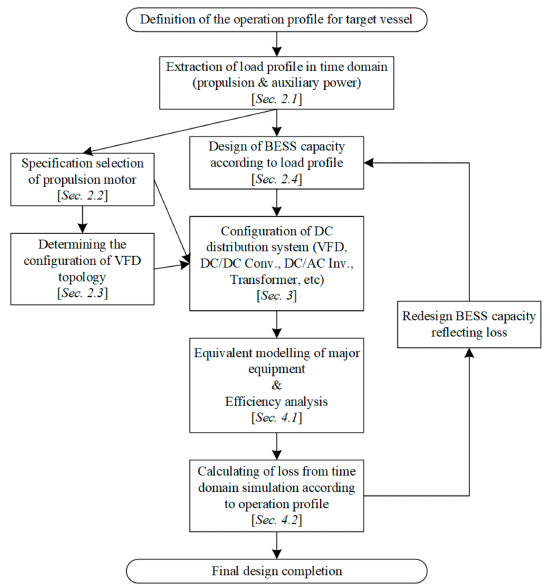
Figure 30. Workflow chart for comprehensive design of DC shipboard power system for pure electric propulsion ship based on